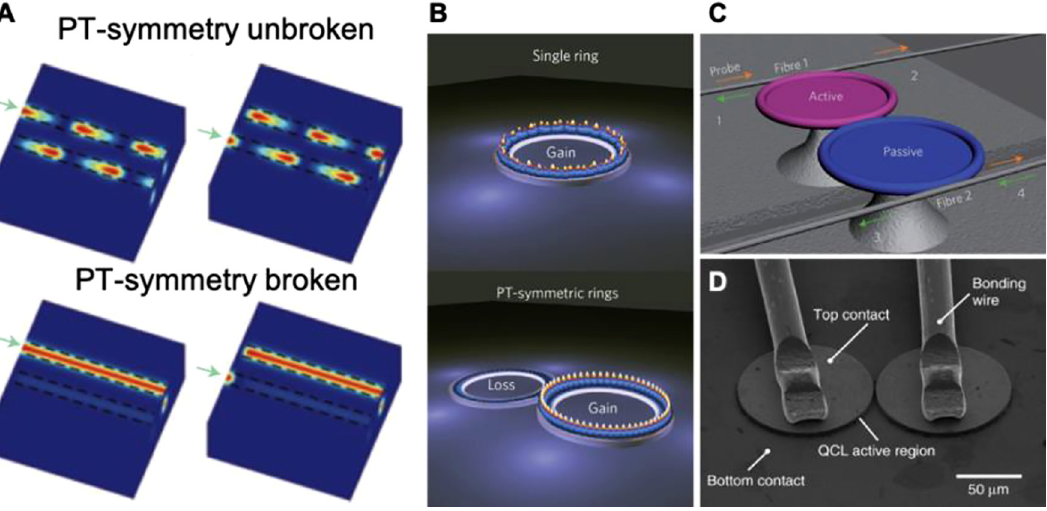
Figure 1: PT symmetry in optics. (A) Different regimes associated with parity-time (PT)-symmetry breaking manifested in light propagation dynamics within a non-Hermitian (NH) waveguide coupler [9]. (B) Enforcing single-mode lasing in a pair of PT-symmetric microring resonators, each supporting a multitude